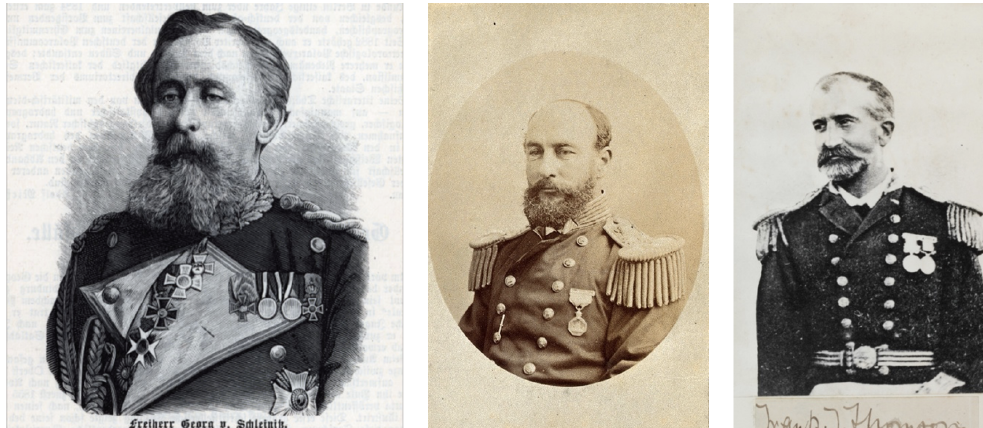
Figure 3. The commanders of the round-the-world voyages: left – Kapitän zur See von Schleinitz (photo dated 1890) (http://www.tripota. uni-trier.de/single_picture.php?signatur=385_1275, last access: 9 April 2022), middle – George Nares (1872–1874) (archives of the National Portrait Gallery, London), and right – Francis Tourle Thomson (1874–1876) (courtesy of Mary Evans Picture Library).